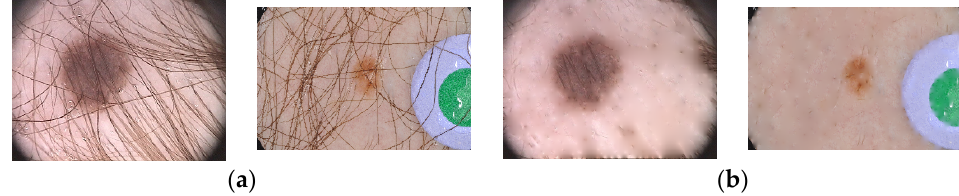
Figure 1. ( a ) Examples of images (IMD003 and ISIC_0002871) with a massive presence of hair; ( b ) the resulting image after the application of saliency shape color for hair removal (HR-SSC).